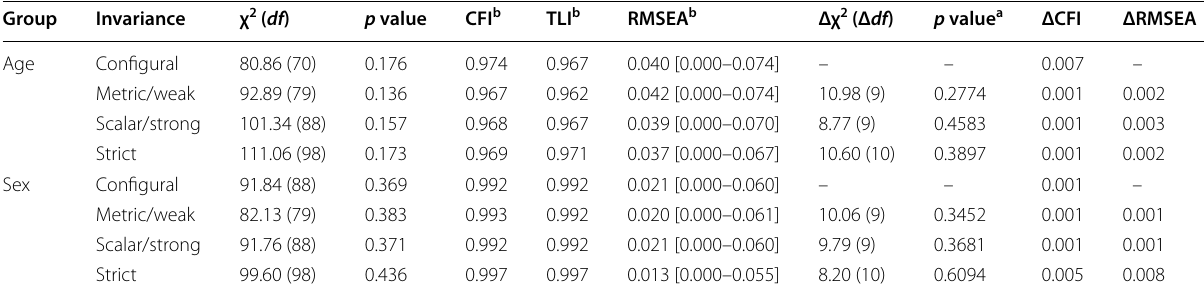
a The chi-square difference value is not significant. It indicated that constraining the parameters of the nested model did not significantly worsen the fit of the model. Our result indicated measurement invariance b Criteria for an acceptable fit were a root mean square error of approximation of < 0.06, and a comparative fit index (CFI) and a Tucker-Lewis index (TLI) of Configural invariance—no constraints; Full metric invariance—with all factor loadings constrained equal. Scalar invariance—with all intercepts constrained equal; Strict invariance—with all factor loadings and intercepts fixed; Measurement invariance is assumed when ΔCFI is